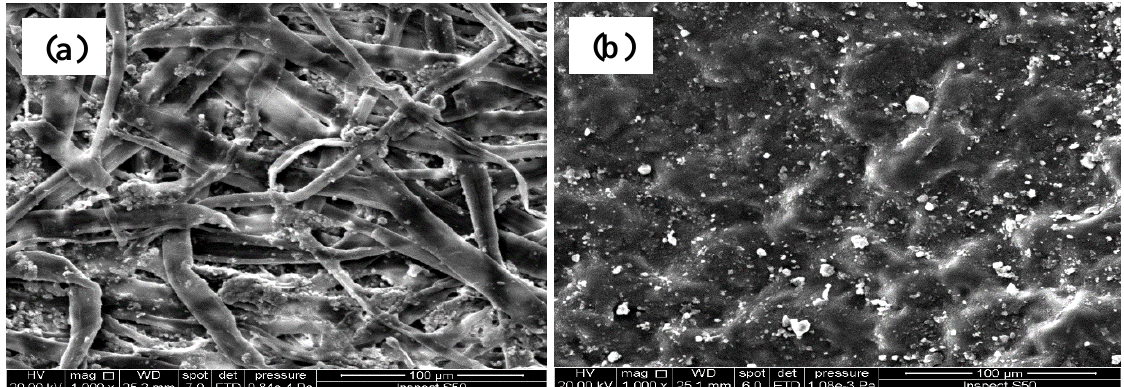
Fig. 9: Scanning electron micrographs of mortars reinforced with (a) waste paper (b) natural